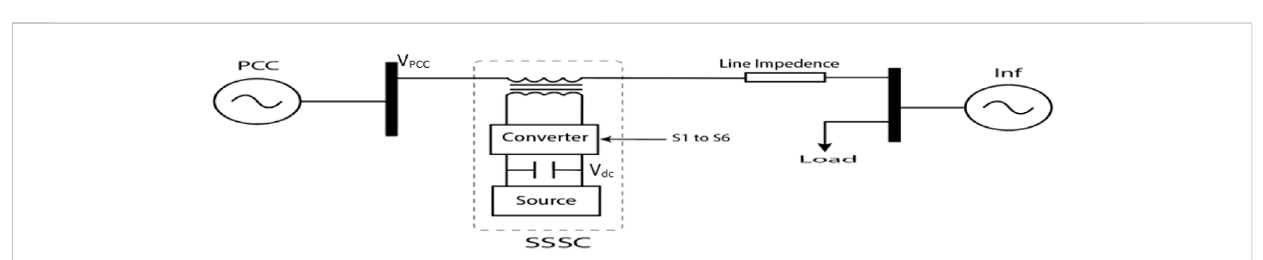
FIGURE 2 Detailed system model of an SSSC without a control.